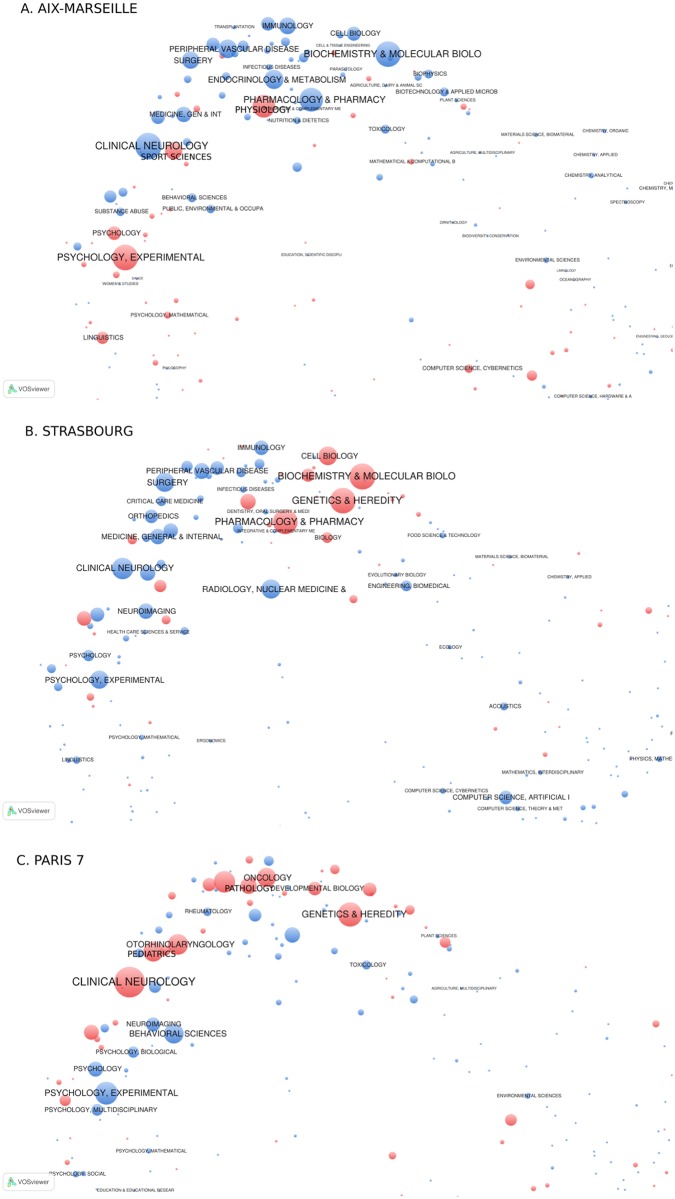
Overlay maps of reference categories in Neuroscience publications A: Aix-Marseille, B: Strasbourg and C: Paris 7.Bubble sizes are proportional to the absolute value of the (world centred) contribution of each category, red when the university contribution is larger than the world, blue if it is smaller. Categories are labelled if their contribution is significantly different from the world (level 1%). Input data for VOSviewer in S2 Table.